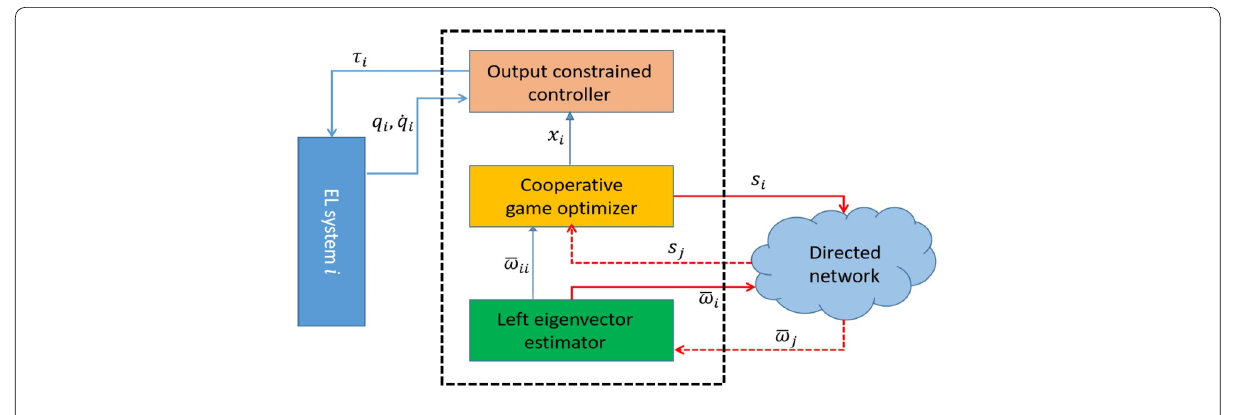
Figure 1 Schematic of the proposed algorithm (7a)–(7h), (8a)–(8c),